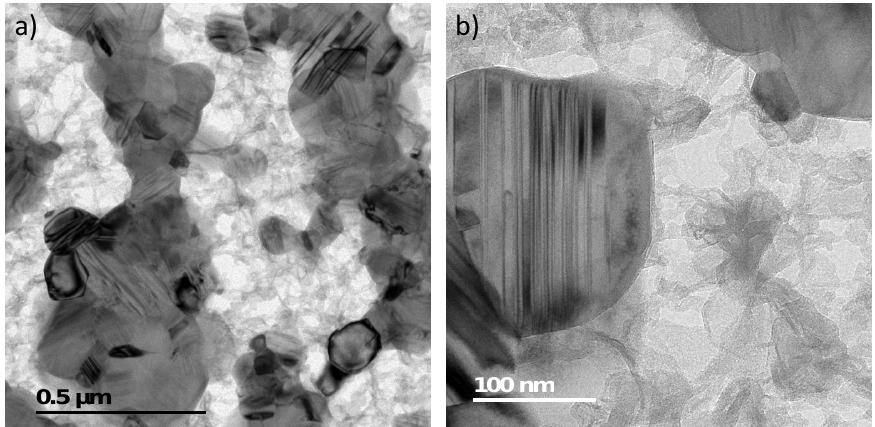
Figure 3. ( a ) Transmission electron microscopy (TEM) view in bright field mode of the cross-linked and pyrolyzed methylphenylvinylhydrogen polysiloxane preceramic polymer sample; ( b ) Detailed view in bright field TEM mode.